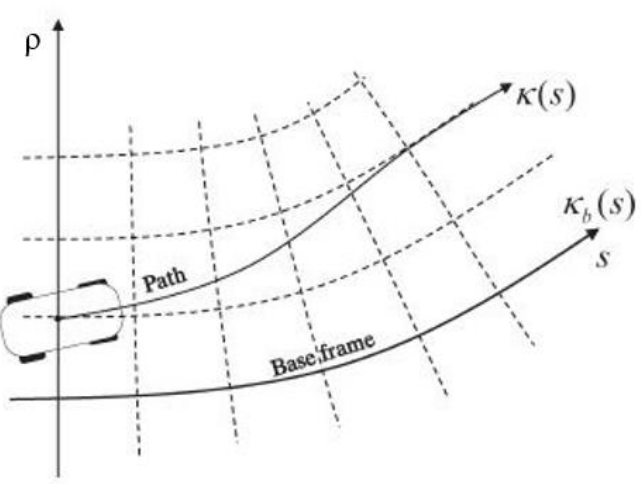
Figure 7. Path candidate and baseline system: the path candidate route follows K ( s ) , which has a close road curvature as the baseline K b ( s )